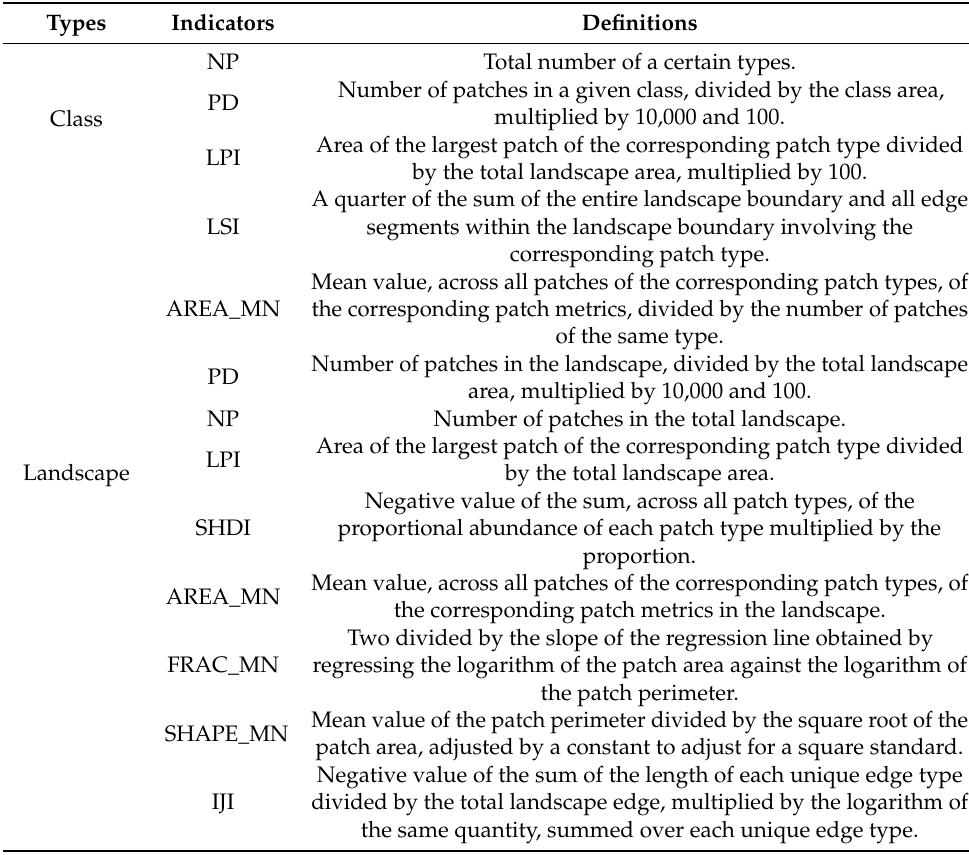
Table 4. Definitions of the indicators (landscape and class metrics) (Note: Referred from the User’s manual of Fragstats Version 4. http://www.umass.edu/landeco/research/fragstats/fragstats.html (2 February